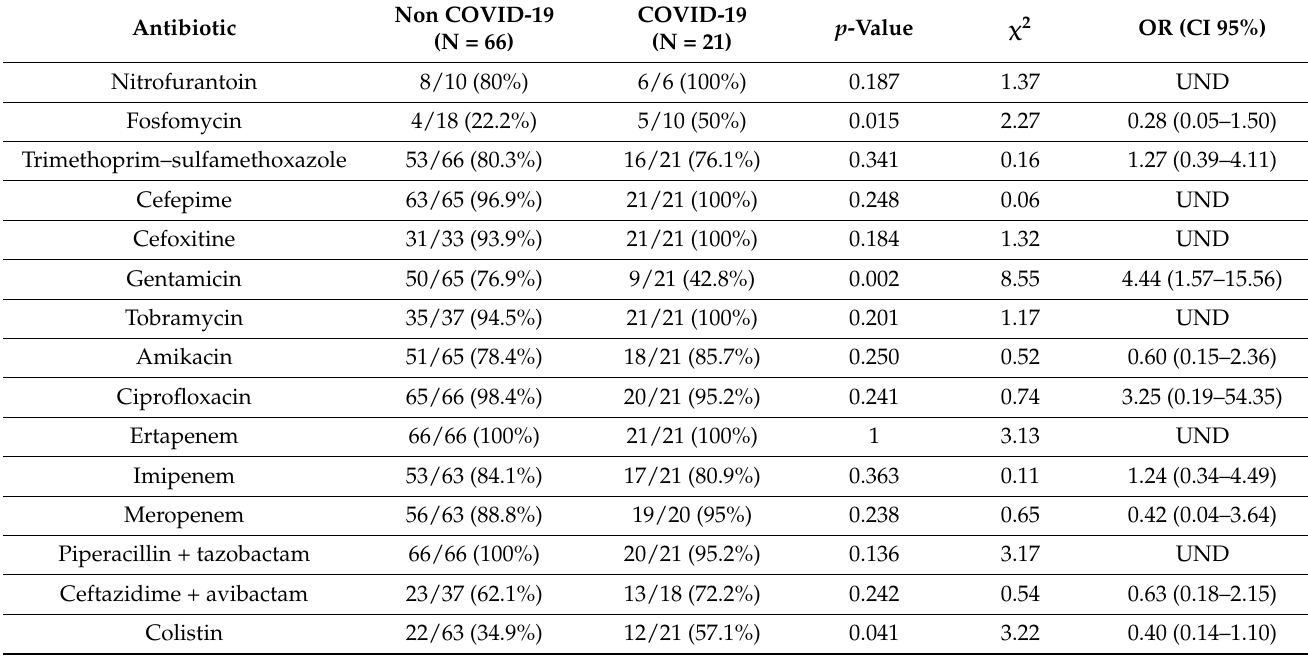
Table 2. Antibiotic resistance rates: COVID-19 versus non-COVID-19.